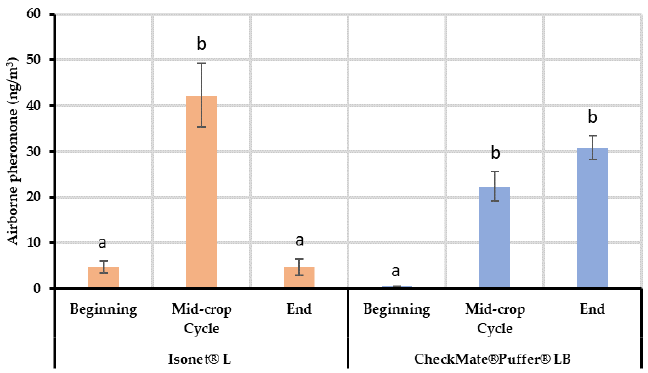
Figure 1. Mean ( ± SE) absolute airborne pheromone concentrations (ng / m 3 ) in vineyards treated with passive dispensers (Isonet ® L) and aerosol devices (CheckMate ® Pu ff er ® LB). Air samples were collected at three moments during the crop cycle: (1) the beginning of the crop cycle (second week of May to middle June), (2) in the middle of the crop cycle (last week of July–first week of August) and (3) at the end of the crop cycle (second to third week of September). Data of each type of dispenser were analyzed separately by applying an ANOVA followed by the Fisher least significant di ff erence (LSD) test ( p < 0.05). Bars labeled with di ff erent letters for each type of dispenser are significantly different.